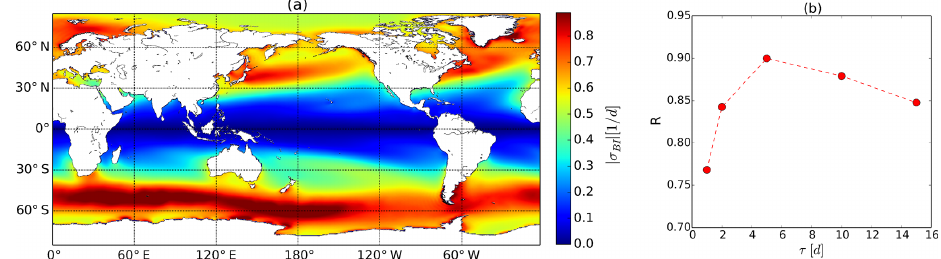
Figure 2. (a) Time average for 35 years of the baroclinic Eady growth rate, Eq. (4), calculated at 850hPa. (b) Correlation index R between σ BI and the 35-year time-averaged forward FTLE map shown in Fig. 1b for different integration times τ .